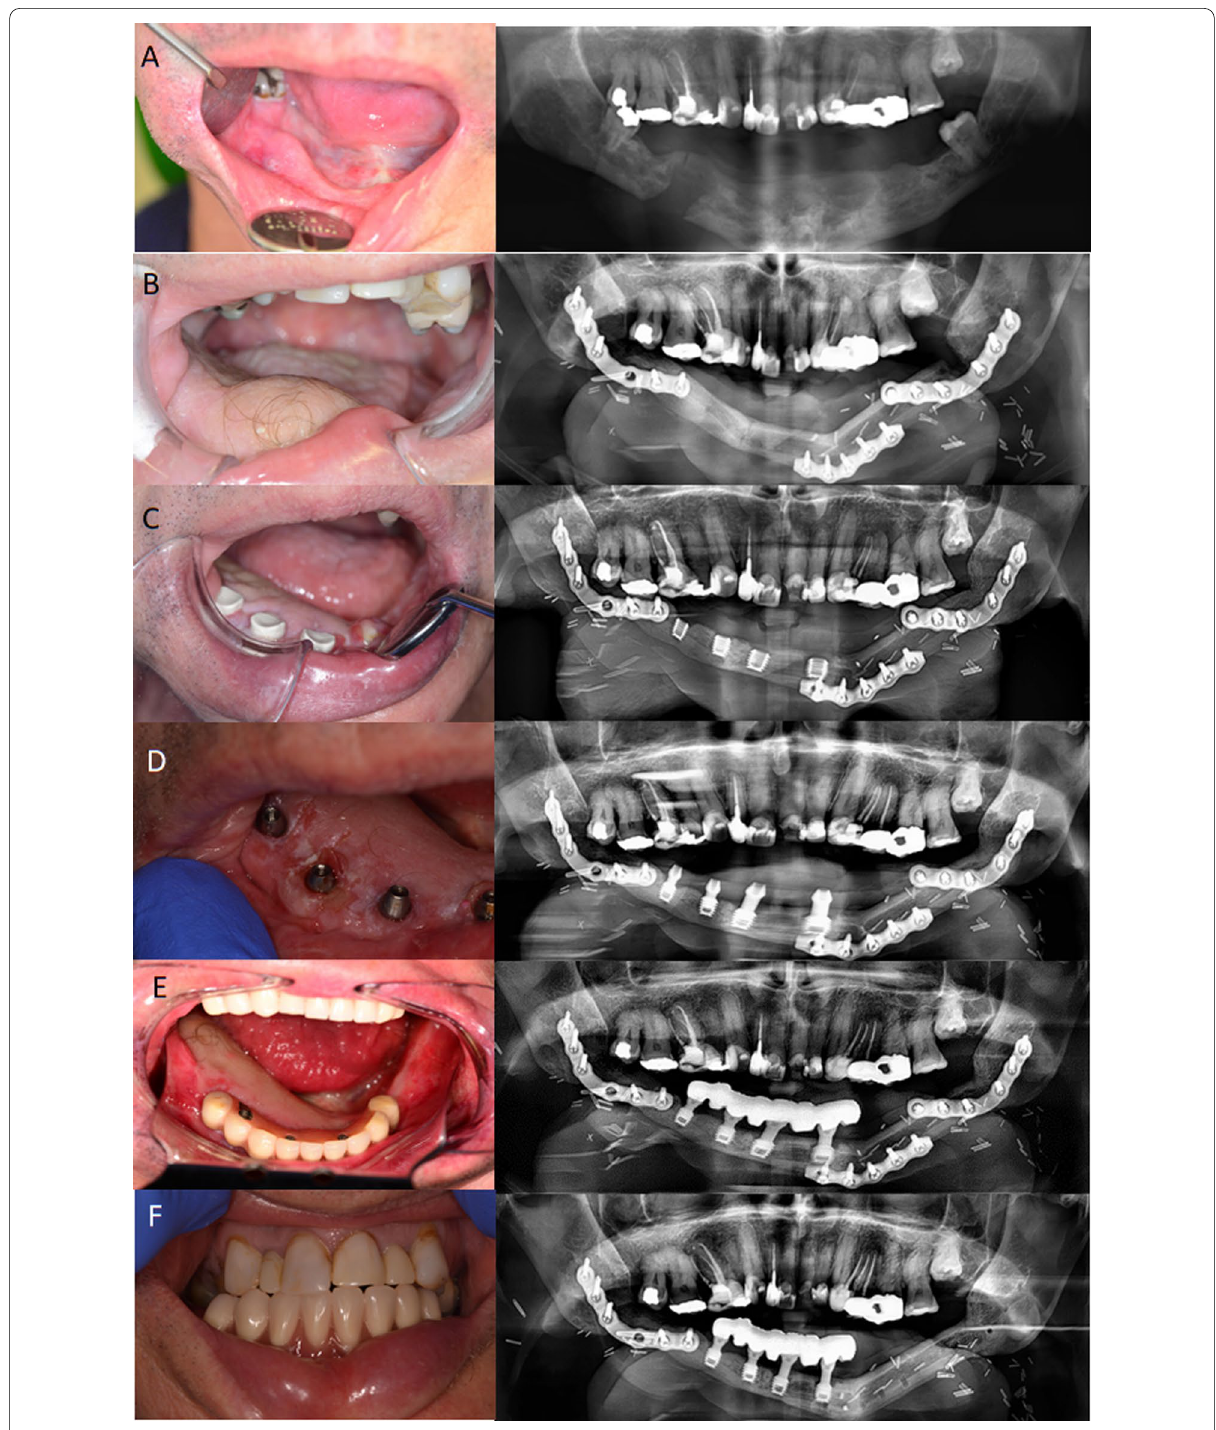
Fig. 1 Clinical photos and panoramic radiographs of a 60 6-year-old male patient diagnosed with mandibular osteoradionecrosis with mandibular reconstruction. A Intraoral photo and panoramic radiography before reconstructive surgery; B intraoral photo and panoramic radiography after mandible reconstruction; C intraoral photo and panoramic radiography after dental implant placement; D the stability of inserted implants were well after 6 months and implant abutments were installed; E fitting restorations are stable in situ after superstructure and dentures installment; F a stable occlusal relationship was confirmed after 5 years